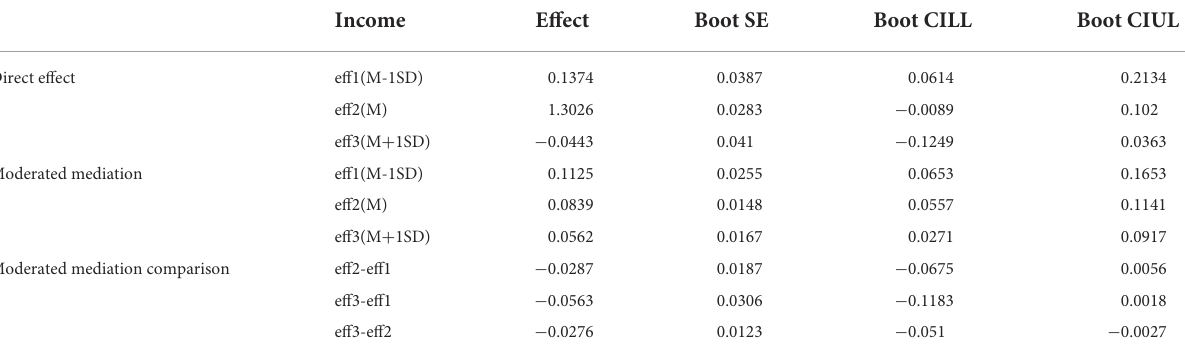
TABLE 7 Mediating effect at different income